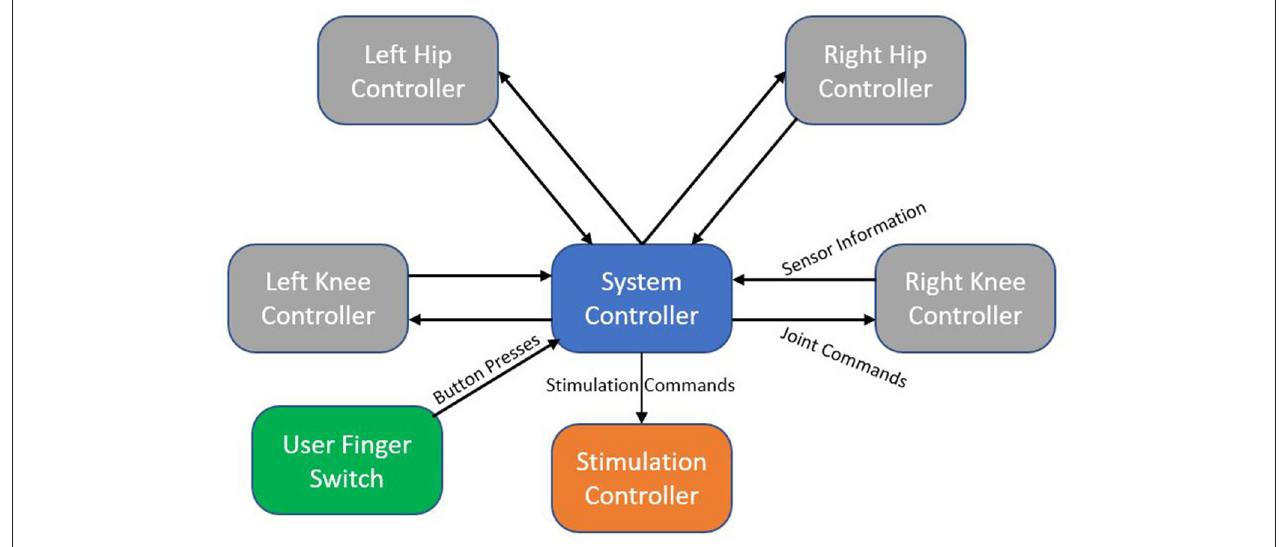
FIGURE 4 | System architecture block diagram. Each node represents an independent microcontroller. Arrows show the flow of information from one node to another.